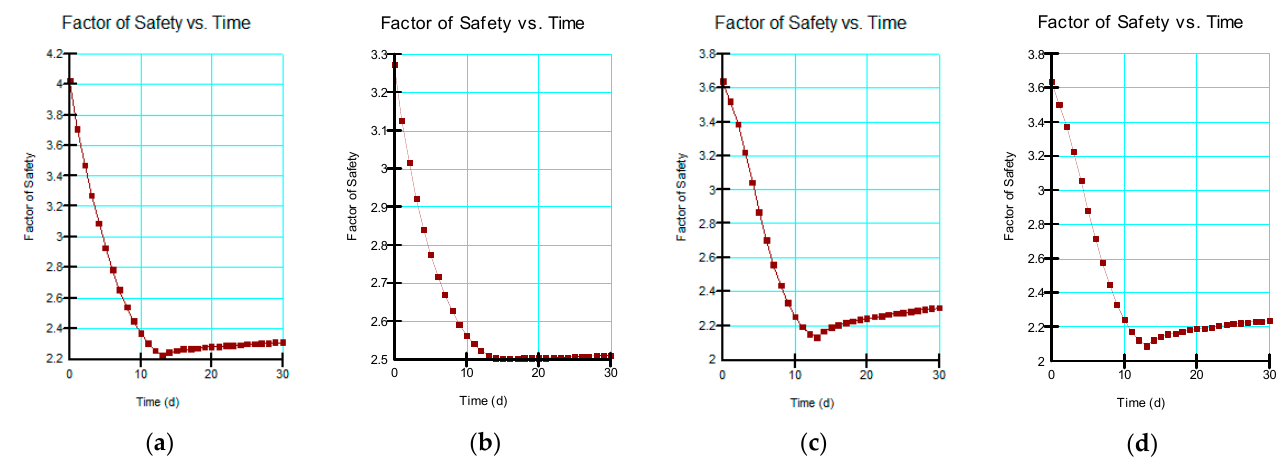
Figure 10. Drawdown of 1 m per day: ( a ) normal operating reservoir level, ( b ) reduced operating reservoir level, ( c ) embankment height operating reservoir level, ( d ) overflow operating reservoir level.